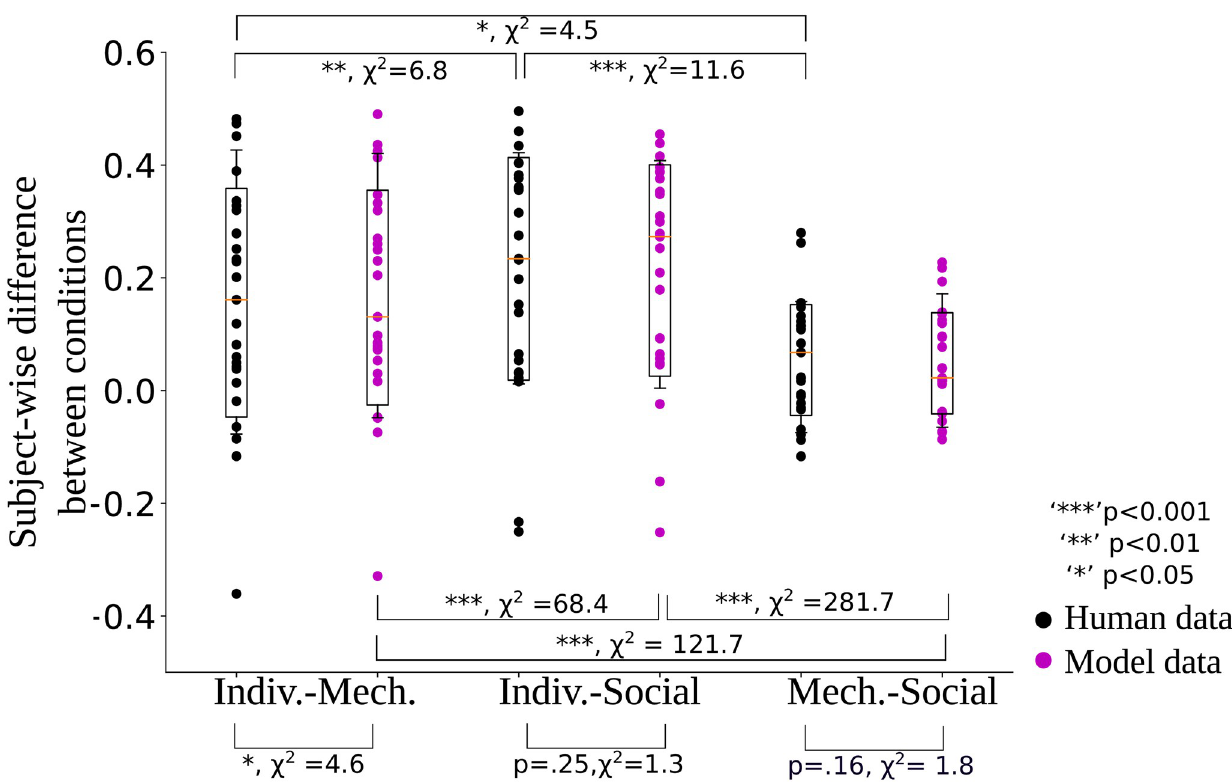
Fig 4. Subject-wise differences between different conditions, compared for human data (black) and model data (magenta) for one trained example network. Boxes indicate the mean, and 80% confidence intervals of the data, fliers indicate standard deviation. Model data reproduce the main trends of the data, but with slightly lower variability. The p-values were computed using the results of all ten networks, i.e. on 25 samples from the human participants, and 250 (= 10 � 25) samples from the models.